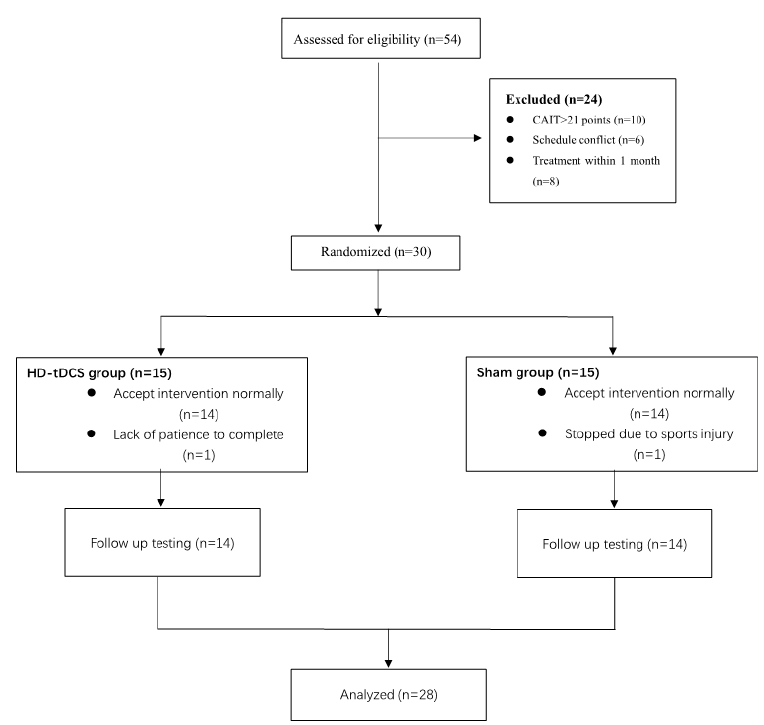
Figure 2. Consort patient flow chart.